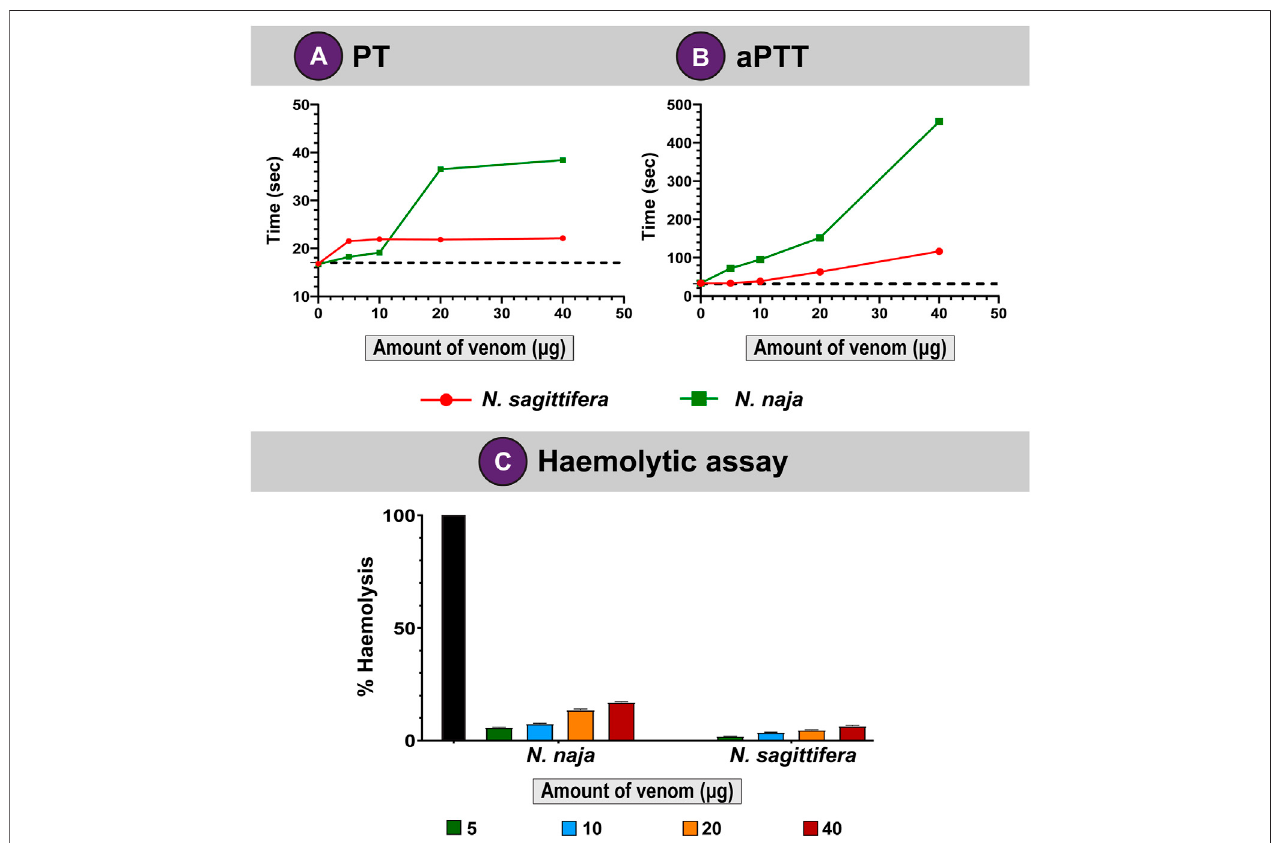
FIGURE4| Coagulopathiesinducedby N.naja and N.sagittifera venoms.Effectsof N.najaandN.sagittifera venomson (A) extrinsicand (B) intrinsicpathwaysare depictedaslinegraphs. (C) Haemolyticabilitiesof N.naja and N.sagittifera venomshavealsobeenshown.Thehorizontaldottedlinein (A,B) indicatetheplasmaclotting time in seconds for the control